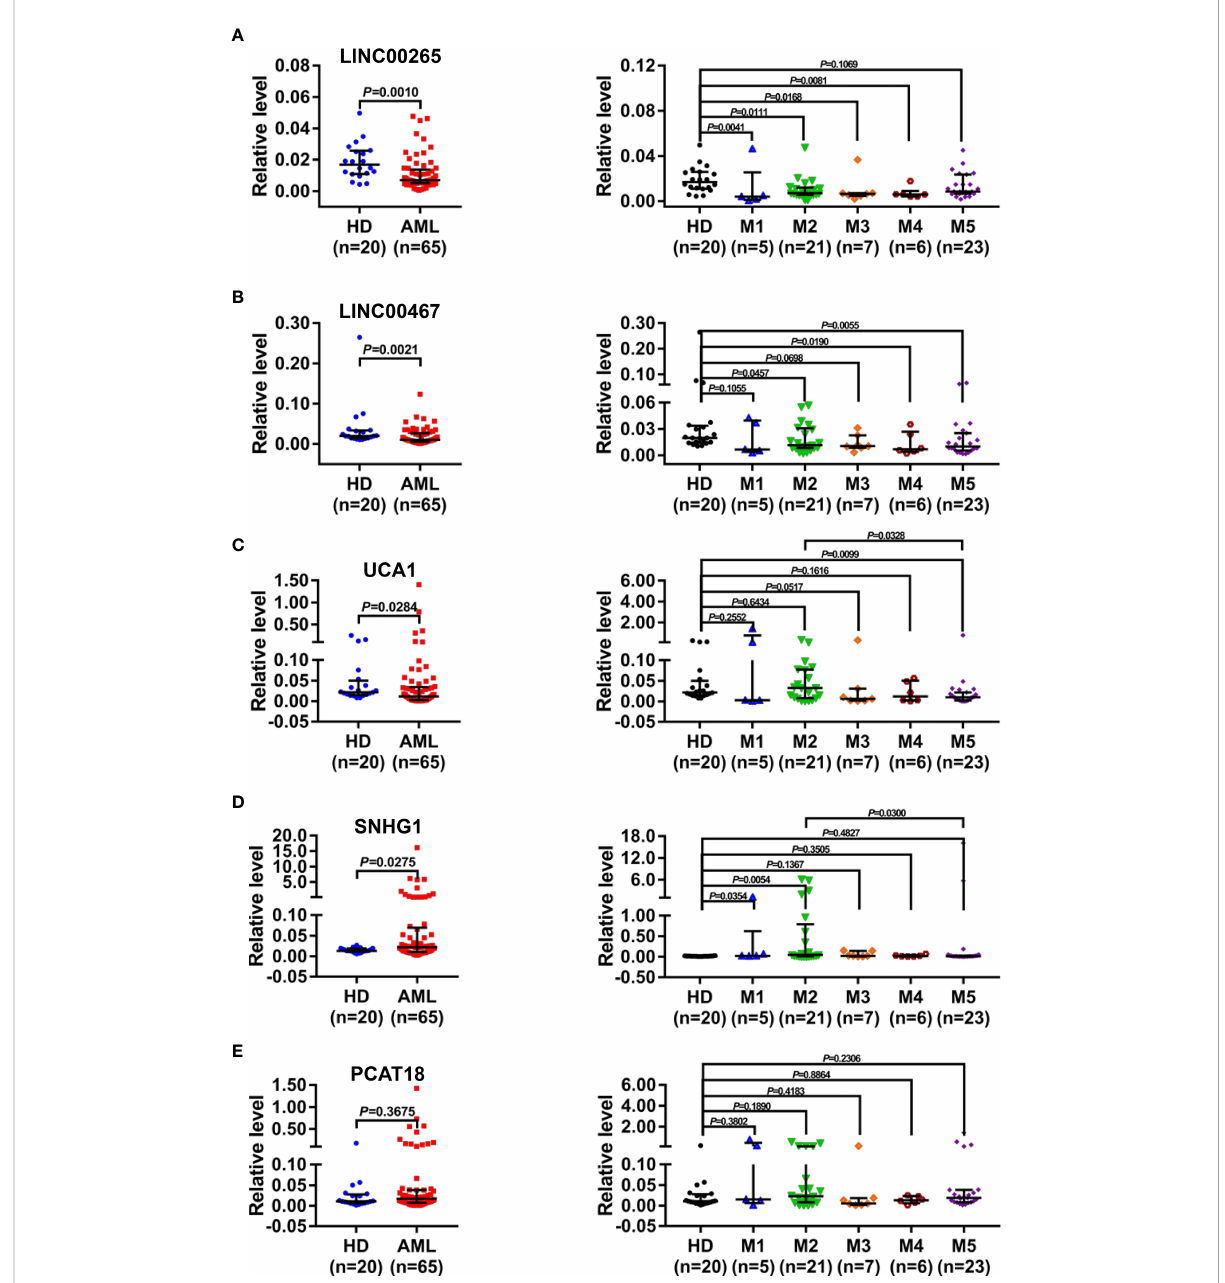
FIGURE 2 Identi fi cation of the Dysregulated Plasma Exosomal LncRNAs in AML. (A-E, left) qRT-PCR analysis of the level of plasma exosomal lncRNA LINC00265 (fold change=0.41, P = 0.0010), LINC00467 (fold change=0.53, P = 0.0021), UCA1 (fold change = 0.53, P = 0.0284), SNHG1 (fold change = 1.67, P = 0.0275), and PCAT18 in healthy donors (HD) (n = 20) and newly diagnosed AML patients (n = 65). The Shapiro-Wilk normality test was performed to test normality, and then the Mann-Whitney U test was used to compare differences between two groups and determine P values. (A-E , right ) Comparison of the level of fi ve plasma exosomal lncRNAs in HD (n = 20), patients with the M1 (n = 5), M2 (n = 21), M3 (n = 7), M4 (n = 6), and M5 (n = 23) subtype. M1-M5 are different French-American-British subtypes of AML (M1: Acute myeloblastic leukemia without maturation; M2: Acute myeloblastic leukemia with maturation; M3: Acute promyelocytic leukemia; M4: Acute myelomonocytic leukemia; M5: Acute monoblastic or monocytic leukemia). The Shapiro-Wilk normality test and Brown-Forsythe test were performed to test normality and homogeneity of variance, and then the Kruskal-Wallis test was used to compare differences among six groups and determine P values. Multiple comparisons included two-stage linear step-up procedure of Benjamini, Krieger and Yekutieli. GAPDH was used as the internal control. Data were presented as the median (interquartile range)